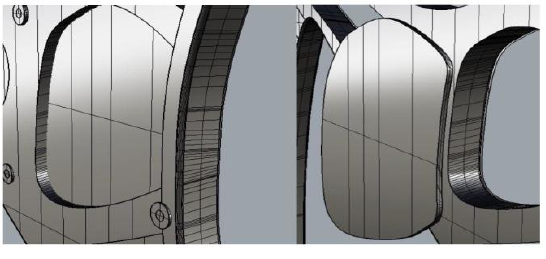
Figure 9. Simple structure and redesign.